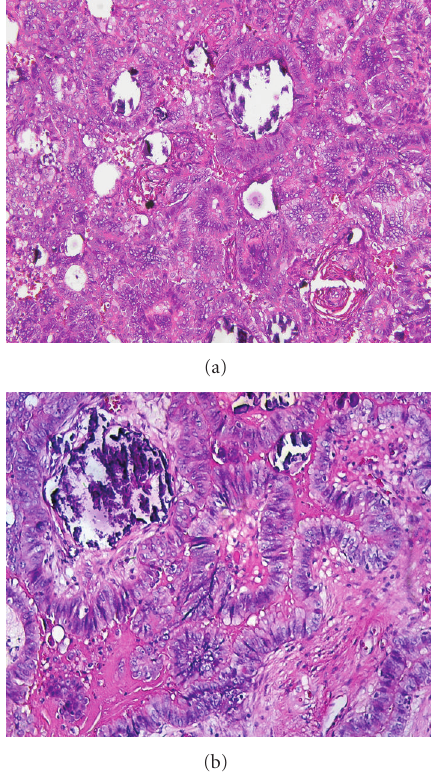
Figure 3: Histological H&E stain of papillary protrusion of the malignant cells filled in the lumen of rete testis. (a) (100x); (b)